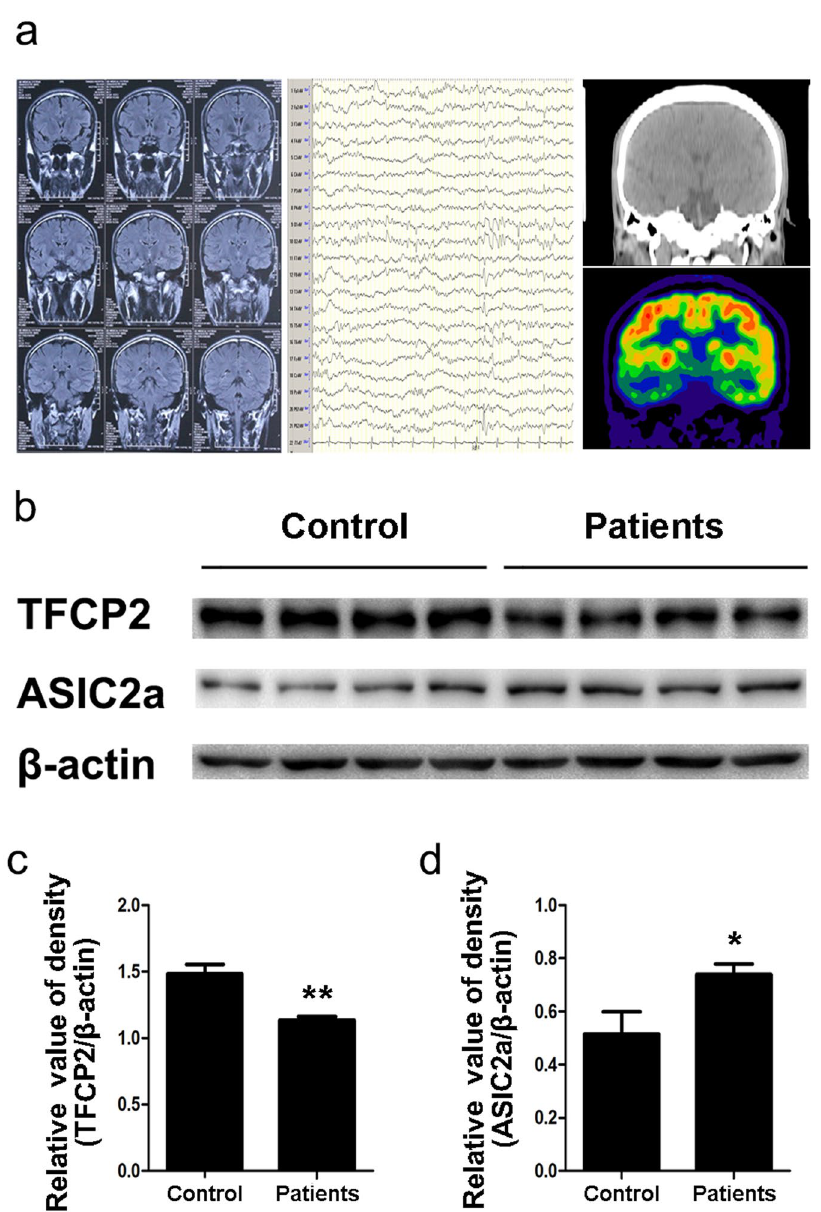
Figure 1. Altered hippocampal TFCP2 and ASIC2a expression with glucose hypometabolism in patients with TLE. ( a ) Patient 4’s pre-surgical assessment results: magnetic resonance imaging (left) was negative, electroencephalography (middle) showed spike waves in the temporal lobe, and fluorodeoxyglucose positron emission tomography (right) revealed hypometabolic lesions in the right hippocampus. ( b ) Representative western blot assays of hippocampal TFCP2 and ASIC2a expression in patients with TLE (n = 13) and control patients (n = 10). β -actin was used as a loading control. ( c , d ) Normalised densitometry bar graphs of TFCP2 and ASIC2a for the control subjects and patients with TLE. The experiments were repeated at least 3 times. Data are presented as means ± standard errors and were analysed using unpaired t-tests. * P < 0.05, ** P < 0.01 compared to controls. Uncropped western blot images are shown in Supplementary Fig. 1. Abbreviations, ASIC2a: acid-sensing ion channel 2a; TFCP2: transcription factor CP2; TLE: temporal lobe TFCP2 and ASIC2a cellular localisation in glucose deficient cells and the CA1 region of epilep- tic rats. TFCP2 and ASIC2a were immunofluorescently labelled in rat CA1 region pyramidal neurons and PC12 cells. In rats and cultured cells, TFCP2 was detected in the cytoplasm and nucleus, while ASIC2a was mainly expressed in the cytoplasm and plasma membrane (Fig. 5a,b). Interestingly, nuclear TFCP2 expression was greatly reduced in the acute phase of epilepsy (Fig. 5a). Moreover, the PC12 cells exhibited decreased nuclear TFCP2 expression after 24 h of growth in low-glucose media, no-glucose media, or 10 µ M STF-31 (Fig. 5b).